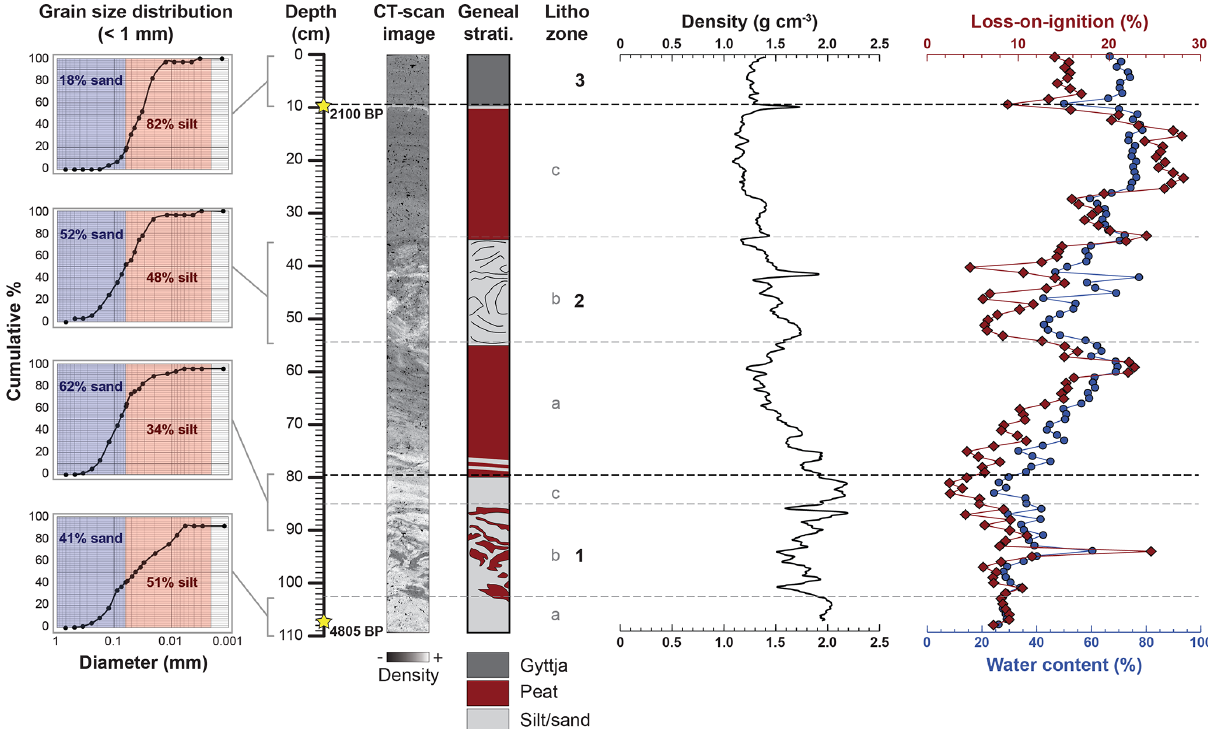
Figure 4. Lithostratigraphy of a sediment core collected in Gull Lake in June 2015. The displayed CT-scan image, as well as visual descriptions and LOI data, was used to split the sedimentary sequence into three distinct units (lithozones). Complete data (Fortier and Bouchard, 2019a, b) are available in open-access files (see “Data availability” section). CT-scan details are summarized in Supplement